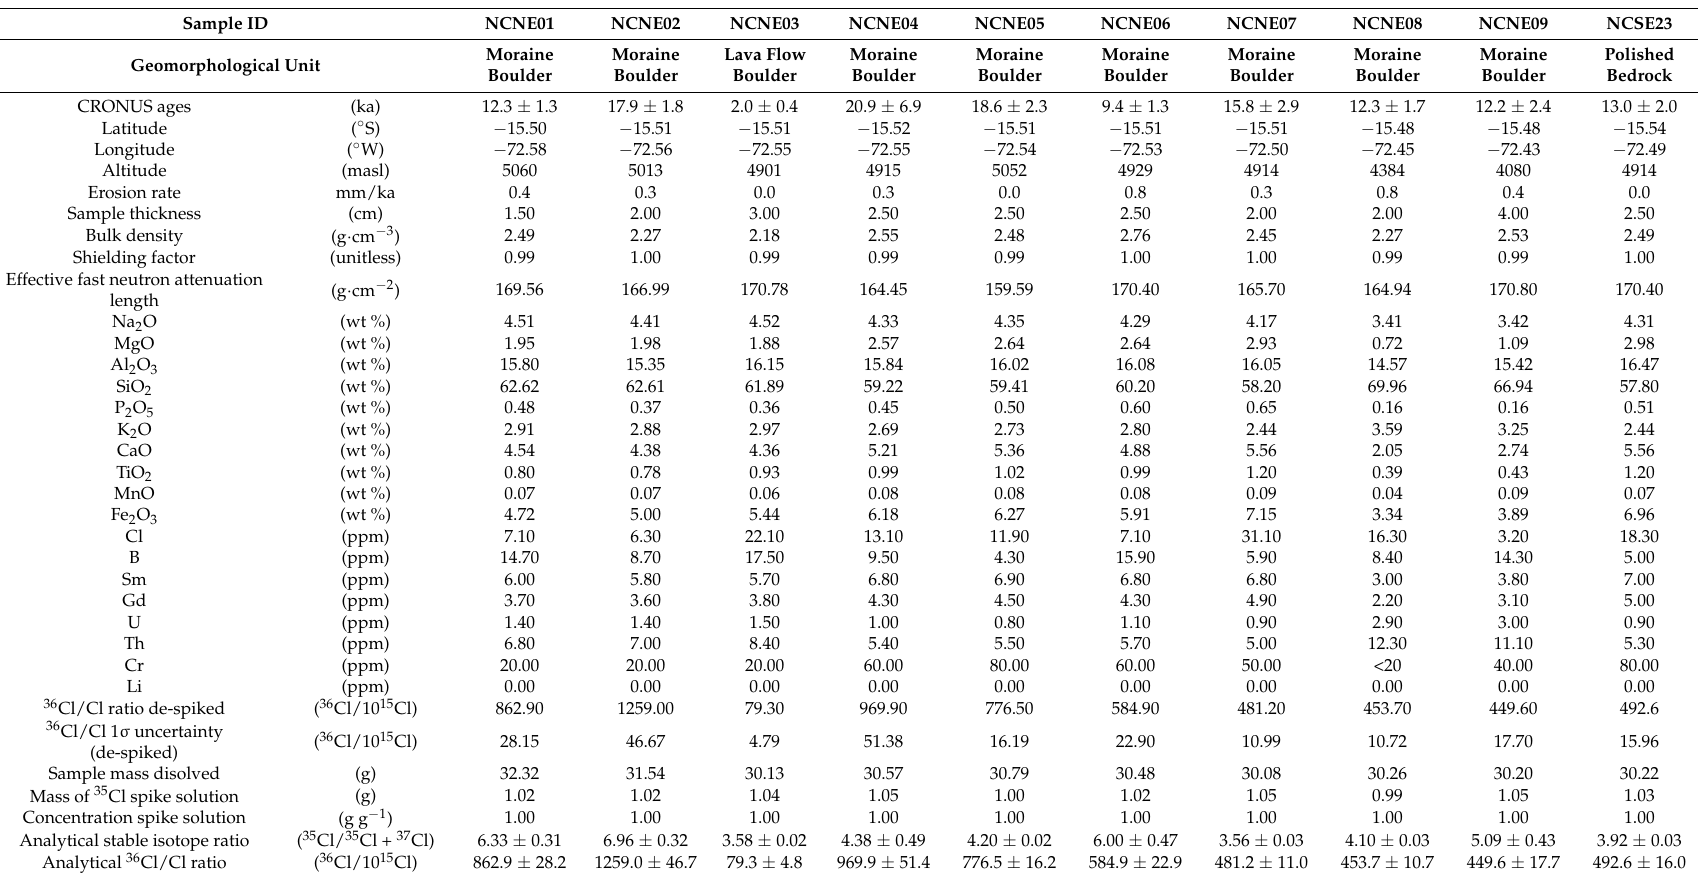
Table 1. Field and analytical data for 36 Cl exposure ages from northeast of Coropuna and